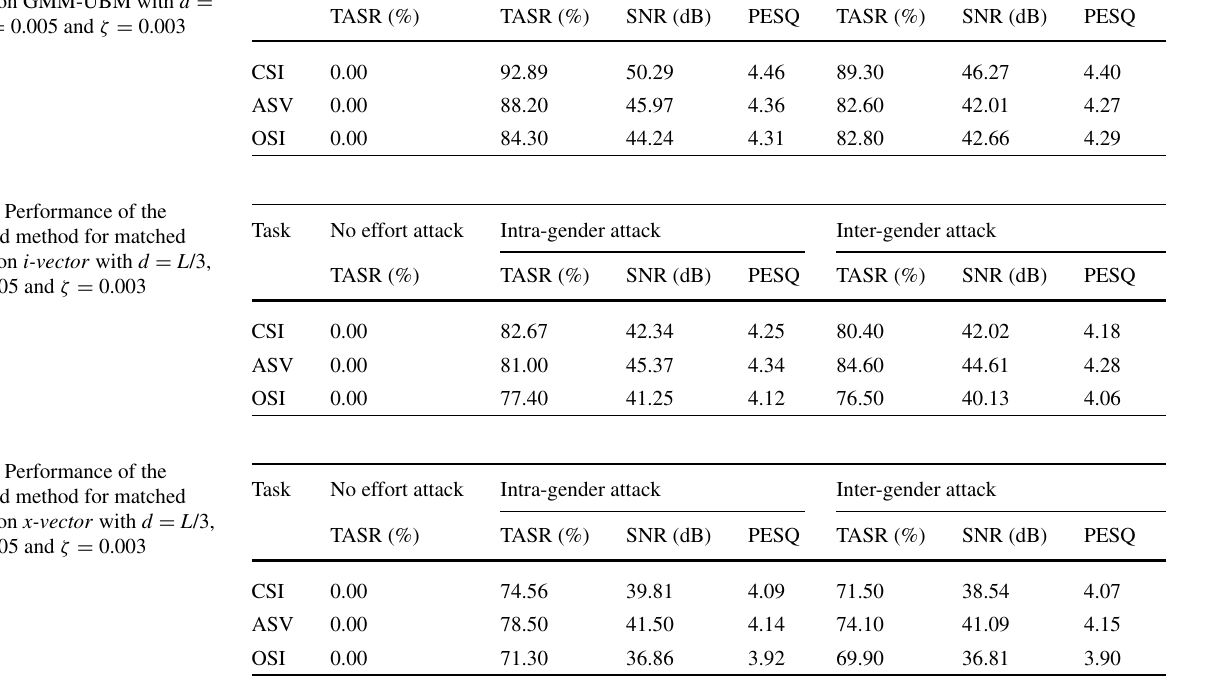
Table 4 Performance of the proposed method for matched attacks on GMM-UBM with d (cid:2)